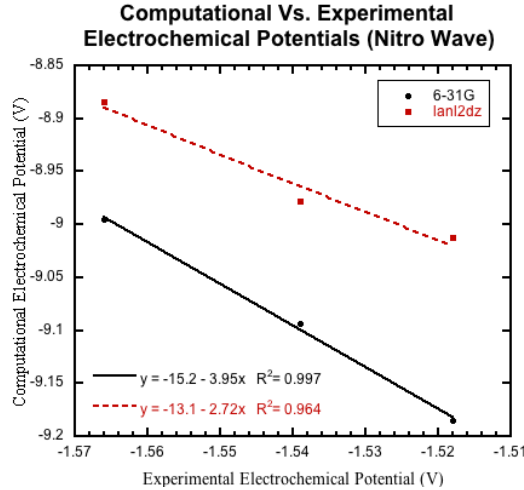
Figure 9. The computationally derived reduction potentials for Nitro Wave compared to the previously reported experimentally measured data [27]. The basis set for lanl2dz is shown in red and 6-31g basis set is shown in black. Derivatives E1–E3 included.